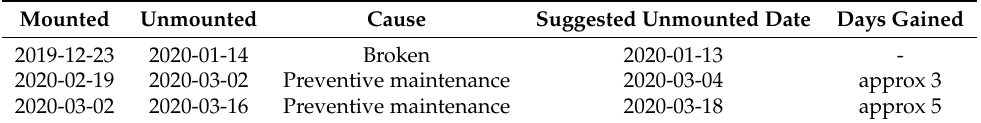
Table 9. Experimental